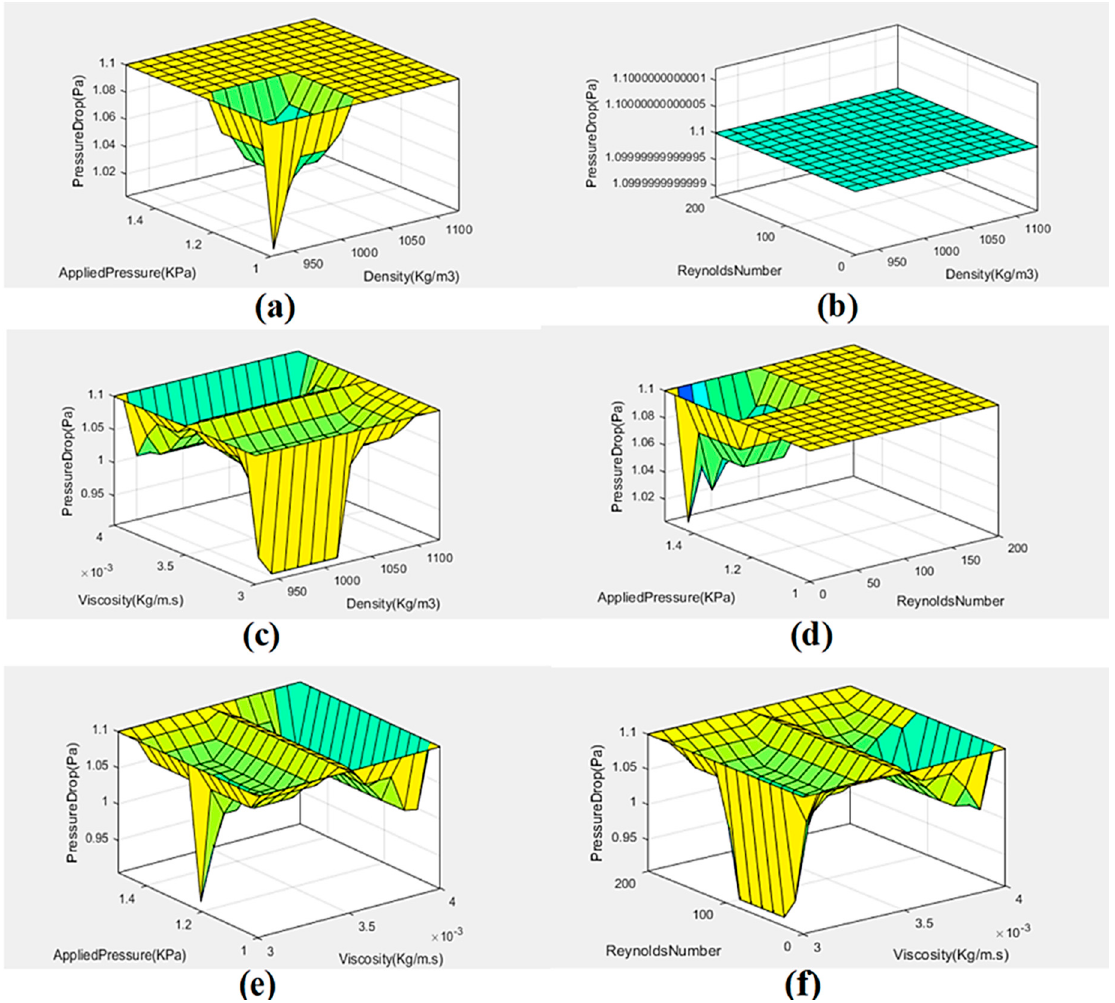
Figure 6. 3D graphical variations with inputs Reynolds number, applied pressure, viscosity, and density with flow rate as output ( a ) Variation for applied pressure with density and pressure drop as output ( b ) Variation for Reynolds number with density and pressure drop as output ( c ) Variation for viscosity with density and pressure drop as output ( d ) Variation for applied pressure with Reynolds number and pressure drop as output ( e ) Variation for applied pressure with viscosity and pressure drop as output ( f ) Variation for Reynolds number with viscosity and pressure drop as output. The three-dimensional graphs obtained for 5CDCMC from Fuzzy logic simulation with flow rate as output are shown below in Figure 7.